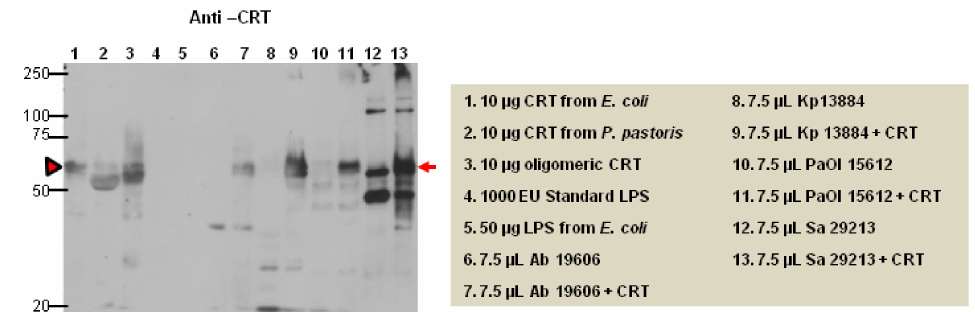
Figure 1. CRT binds to gram-positive and gram-negative bacteria. Recombinant CRT (rCRT) was incubated overnight at 4 ◦ C with three gram-negative bacteria ( Acinetobactor baumannii (Ab), Psuedomonas aeruginosa (PaOI), and Klebseilla pneumonia (Kp) and one gram-positive virulent bacteria ( Staphylococcus aureus (Sa)). The cells were washed thoroughly after lysis and immunoblotted with anti-CRT (PA-3-900). The CRT antibody recognizes rCRT at ~63kDa (lane 1) from bacterial expression (red arrow head), as well as rCRT expressed in yeast (lane 2). Bacterially expressed rCRT (lane 1) contains an additional 23 amino acids at the N terminus (from pBAD plasmid gIII targeting CRT to the periplasmic space of bacteria) causing a slower migration than rCRT expressed in yeast (lane 2). CRT bound to both gram-negative and gram-positive bacteria (lanes 7, 9, 11 13) as shown as the same molecular weight as CRT alone (marked by a red arrow) n =